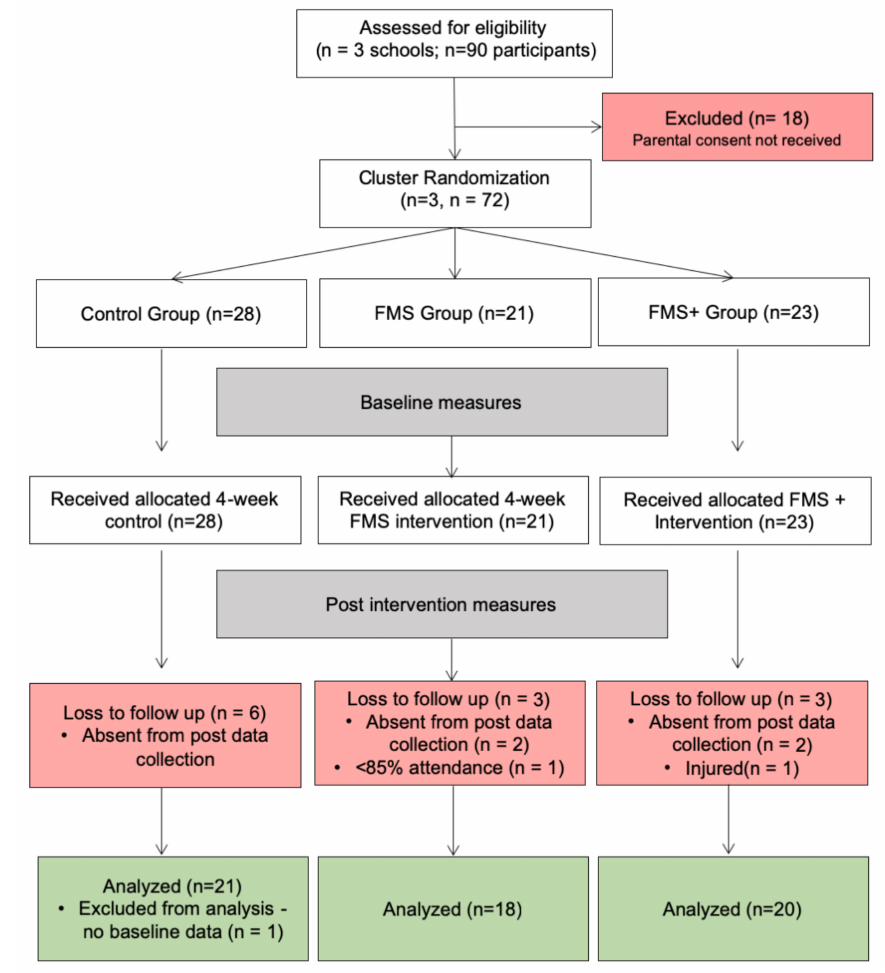
Figure 1. CONSORT flow diagram illustrating the recruitment of participants and those excluded or lost to